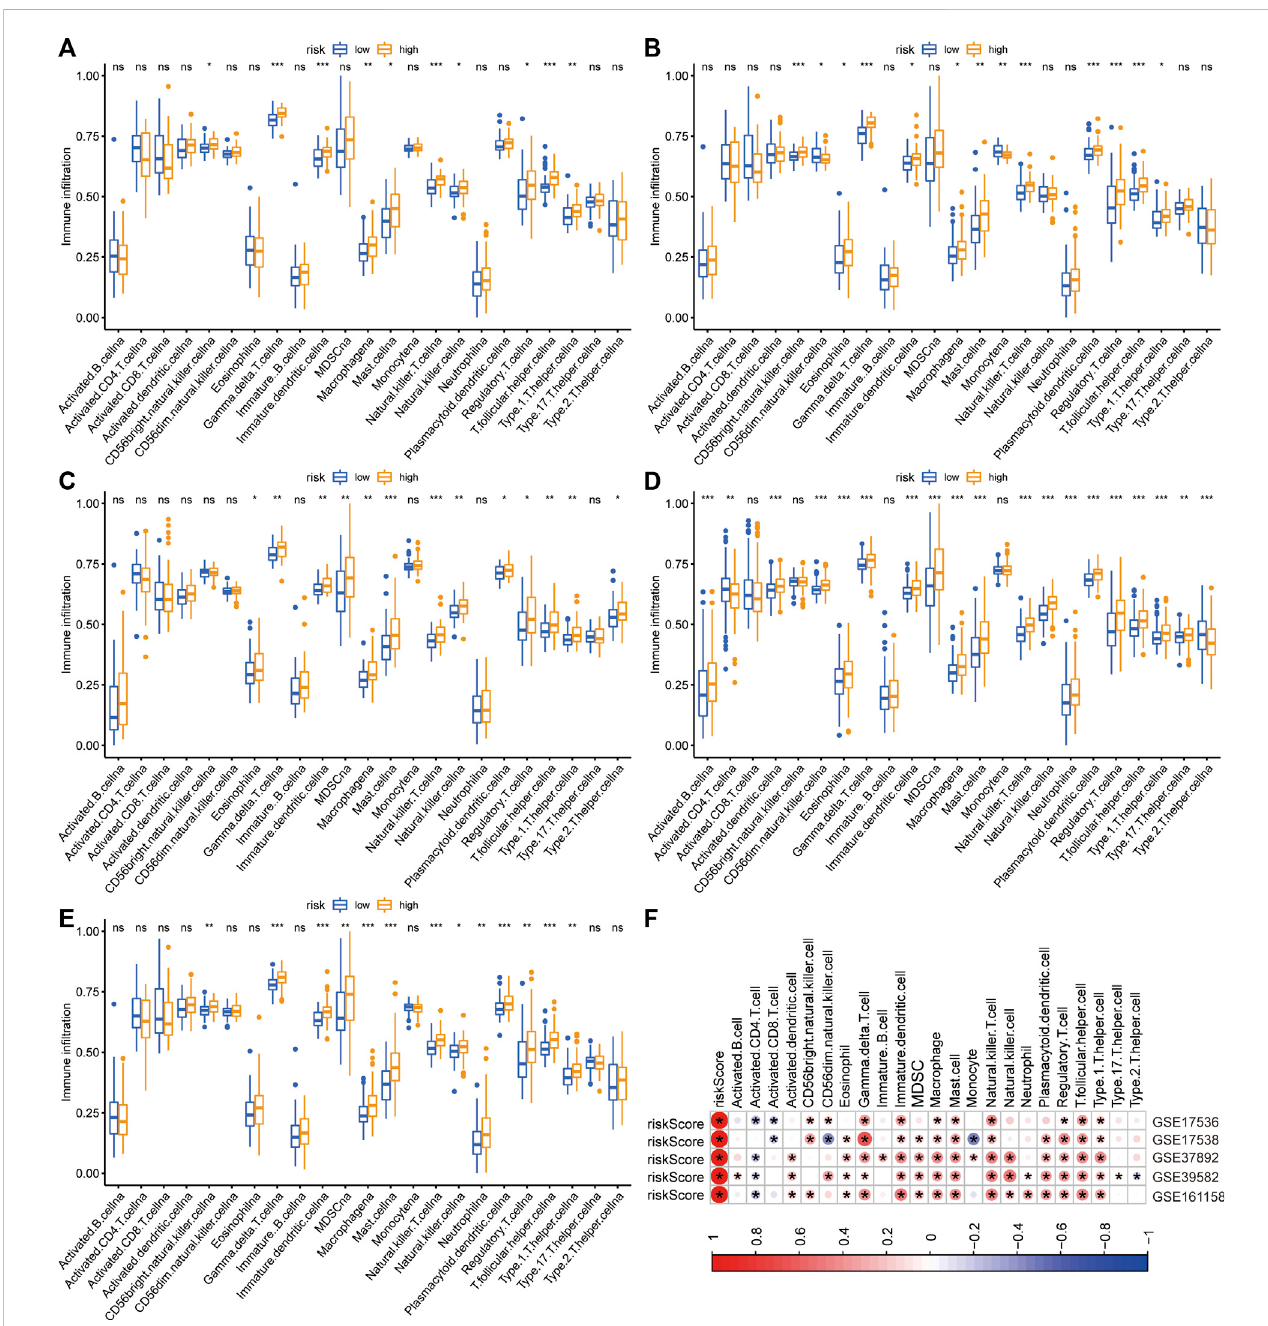
FIGURE 5 Differences in immune in fi ltration between two risk groups. (A – E) The immune in fi ltrative differences between two risk groups in GSE17536 (A) , GSE17538 (B) , GSE37892 (C) , GSE39582 (D) , and GSE161158 (E) cohorts, respectively. (F) The heatmap of correlations between immune in fi ltration and risk signature in each cohort. The blue color indicated negatively related and the red indicated positively related. * p <